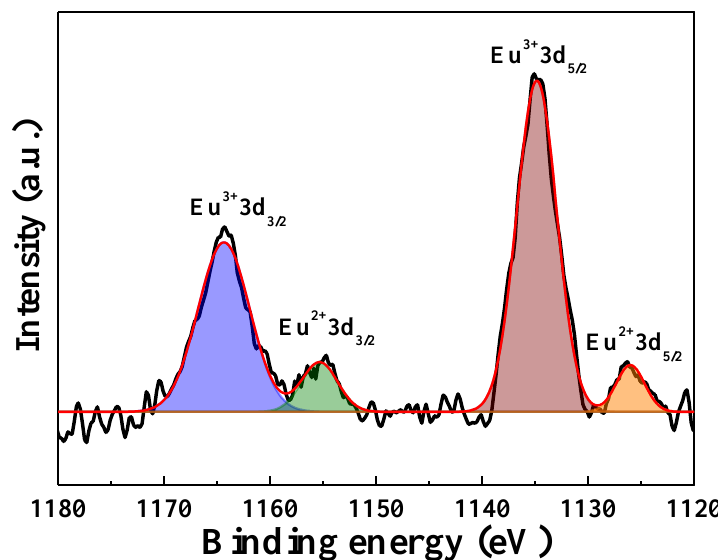
Figure 13. XPS spectra of the [Sr 0.99 Eu 0.01 ] 3 MgSi 2 O 8 phosphors sintered at different temperatures. ( a ) 900 °C and ( b ) 1400 °C.